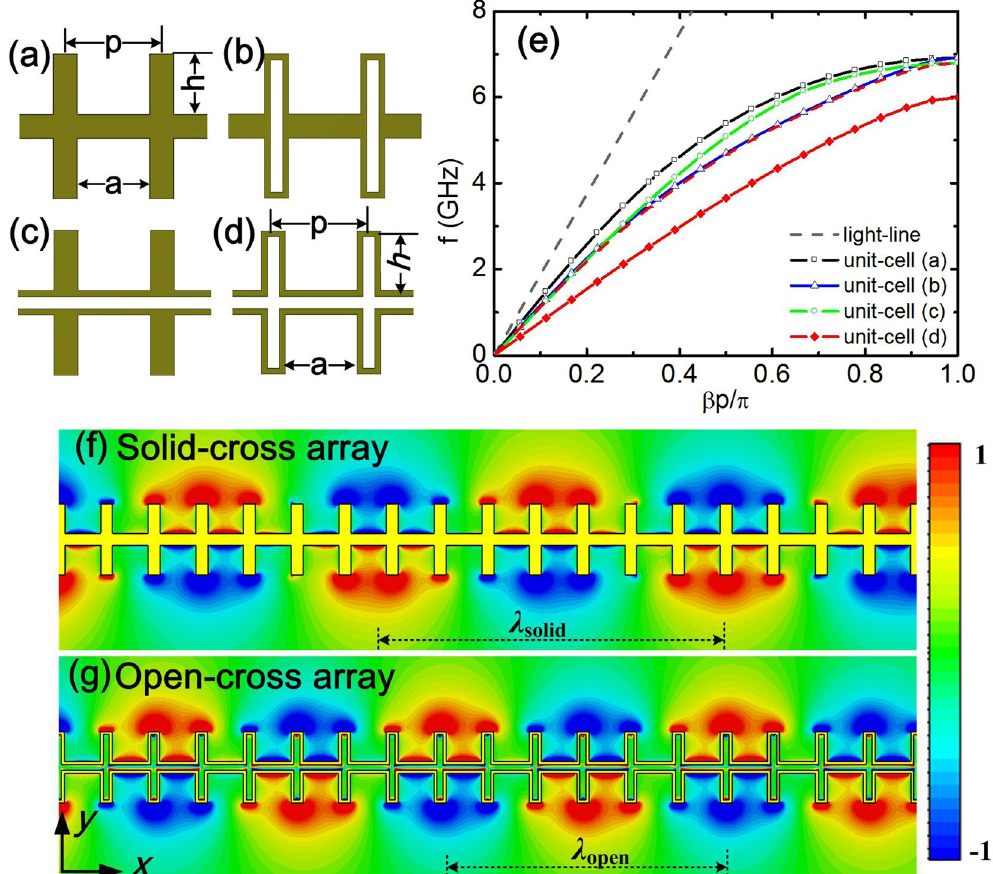
Figure 1. Schematic shapes of unit cell to construct plasmonic arrays: (a) solid-cross; (b) cross with window; (c) double solid-cross; (d) open-cross. The unit cells are formed by patterning 0.018 mm-thick metal film on dielectric substrates with a thickness of 1.524 mm and a permittivity of 3.55. (e) Dispersion relations of the fundamental modes for unit cells with shapes from. (a) to (d) Distribution of the real part of electric field E y at frequency of 3.5 GHz for a solid-cross array (f) and an open-cross array (g)